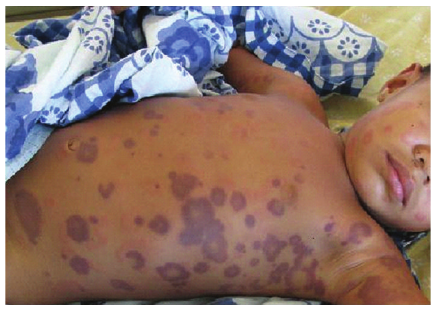
Figure 1: Annular, arcuate, and polycyclic wheals with central clearing and purpuric hue on the trunk.